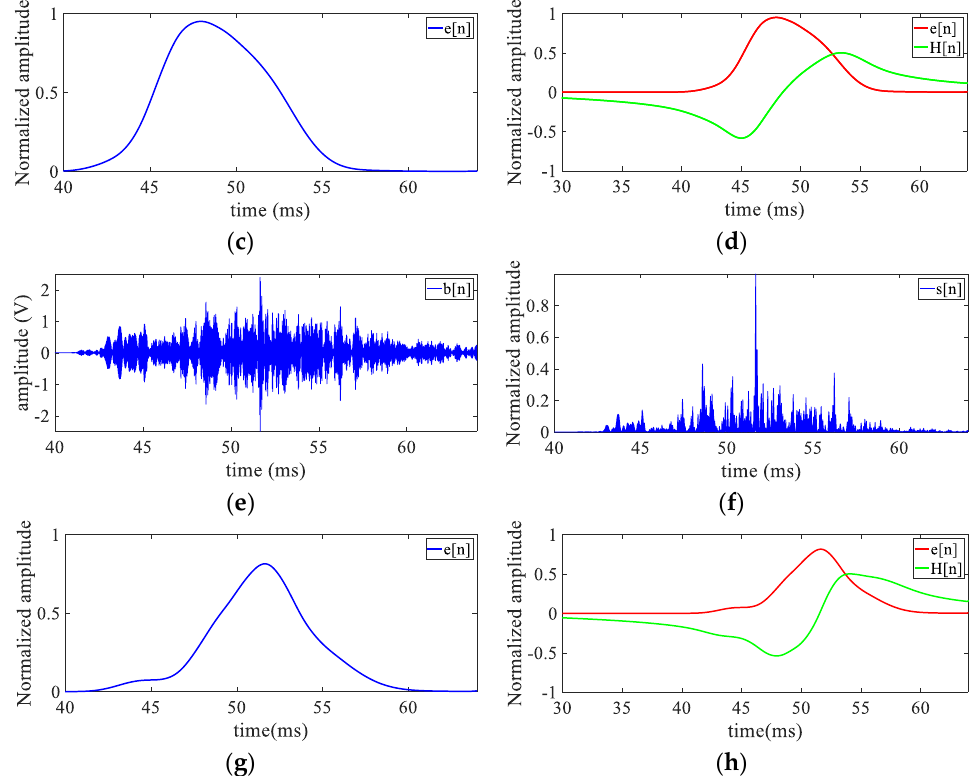
Figure 13. Peak detection of the received signals under different test distances, ( a ) bandpass filtered signal under test distance equaling 100 m, ( b ) the corresponding square transformed signal, ( c ) the corresponding envelope, ( d ) peaks detection results, ( e ) bandpass filtered signal under test distance equaling 200 m, ( f ) the corresponding square transformed signal, ( g ) the corresponding envelope, ( h ) peaks detection results.